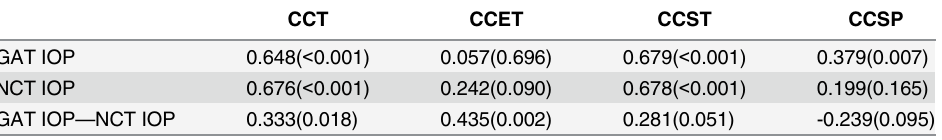
Table 2. Correlations between IOP parameters and central corneal thickness parameters (Pearson correlation coefficient R and P value in parenthesis).